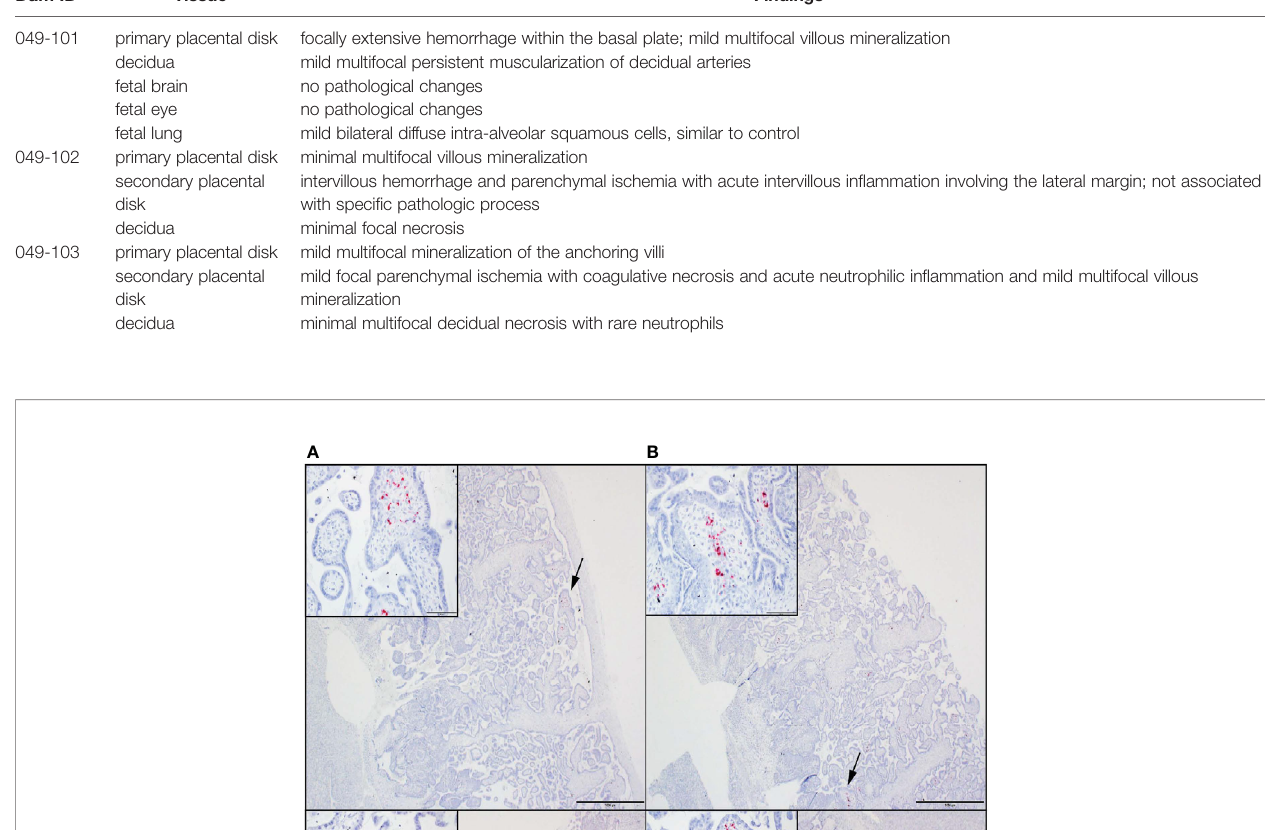
TABLE 4 | Histopathological assessment of placental tissues from all animals and fetal tissues from 049-101. Dam ID Tissue Findings